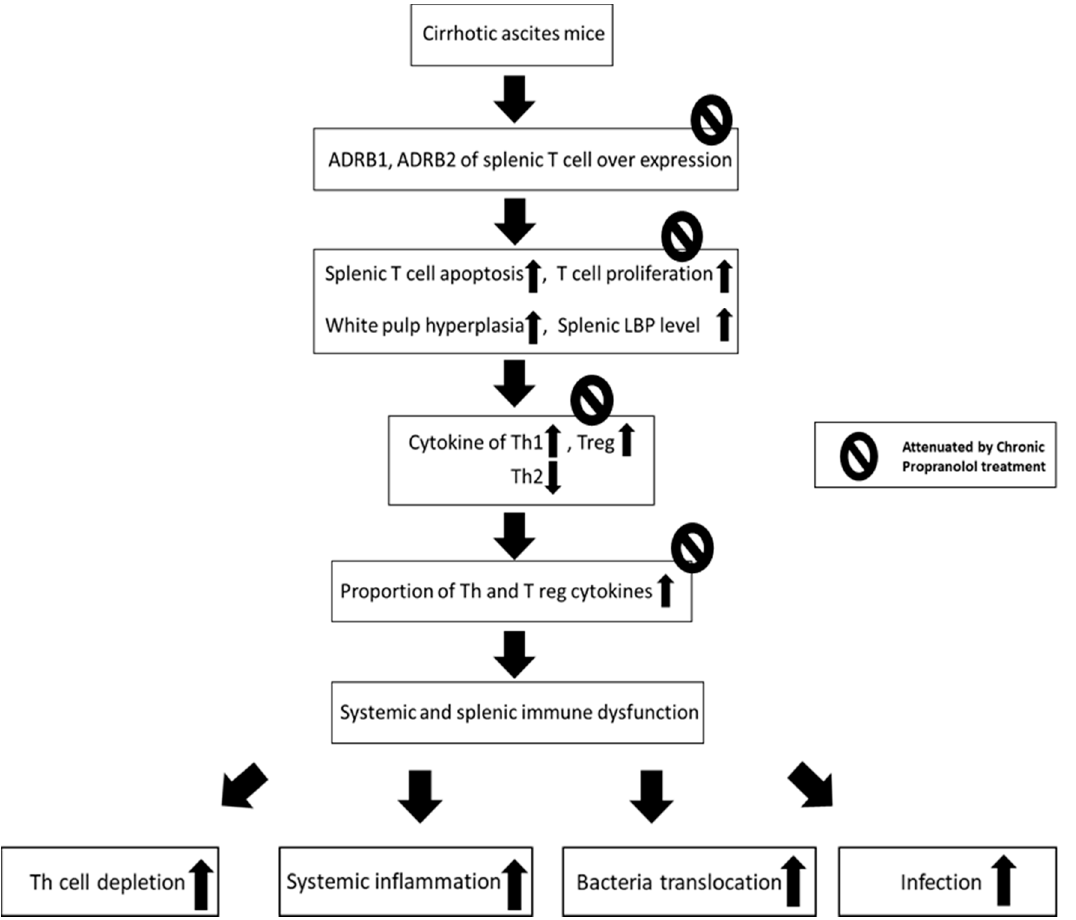
Figure 8. Graphical summary of the effects of chronic propranolol treatment the on the regulation, modulation, and changes that are associated with cirrhosis in terms of sympathetic nervous system (SNS)-activity and T-lymphocytes. SNS, sympathetic nervous system; ADRB1/ADRB2, β 1 and β 2 adrenergic receptors; Th cell, helper T cell; Treg, regulatory T cell.